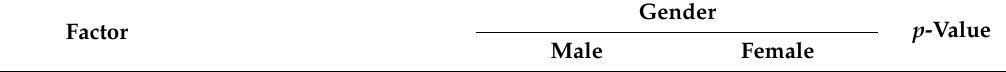
Table 6. Gender-based comparison of weight, dietary habits, smoking, working out, and seden- tary